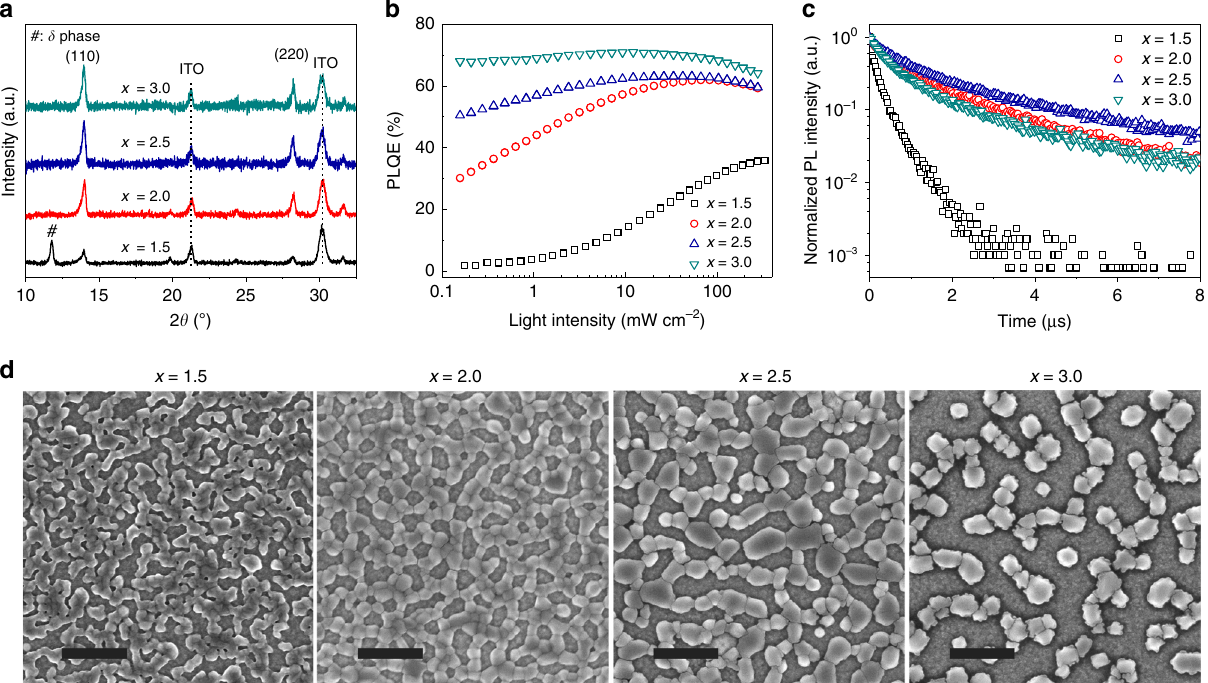
Fig. 2 Perovskite fi lms processed from precursors with different component ratios. a – d XRD patterns ( a ), light-intensity-dependent PLQEs ( b ), PL decays ( c ) and SEM images ( d ) of thermal annealed perovskite fi lms processed from precursors with different x values ( x = 1.5, 2.0, 2.5 and 3.0). The scale bars in the SEM images are 1 µ